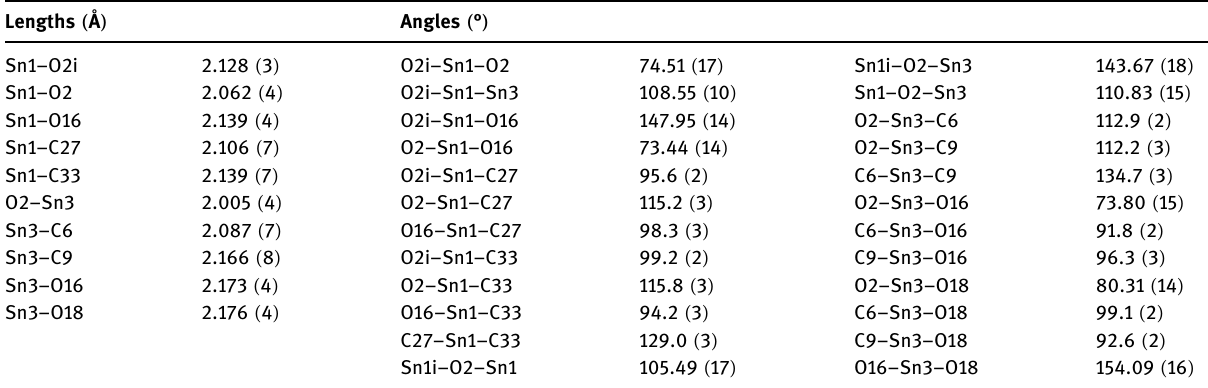
Table 2: Geometric parameters ( Å and ° ) of complex 1 Lengths ( Å ) Angles ( °